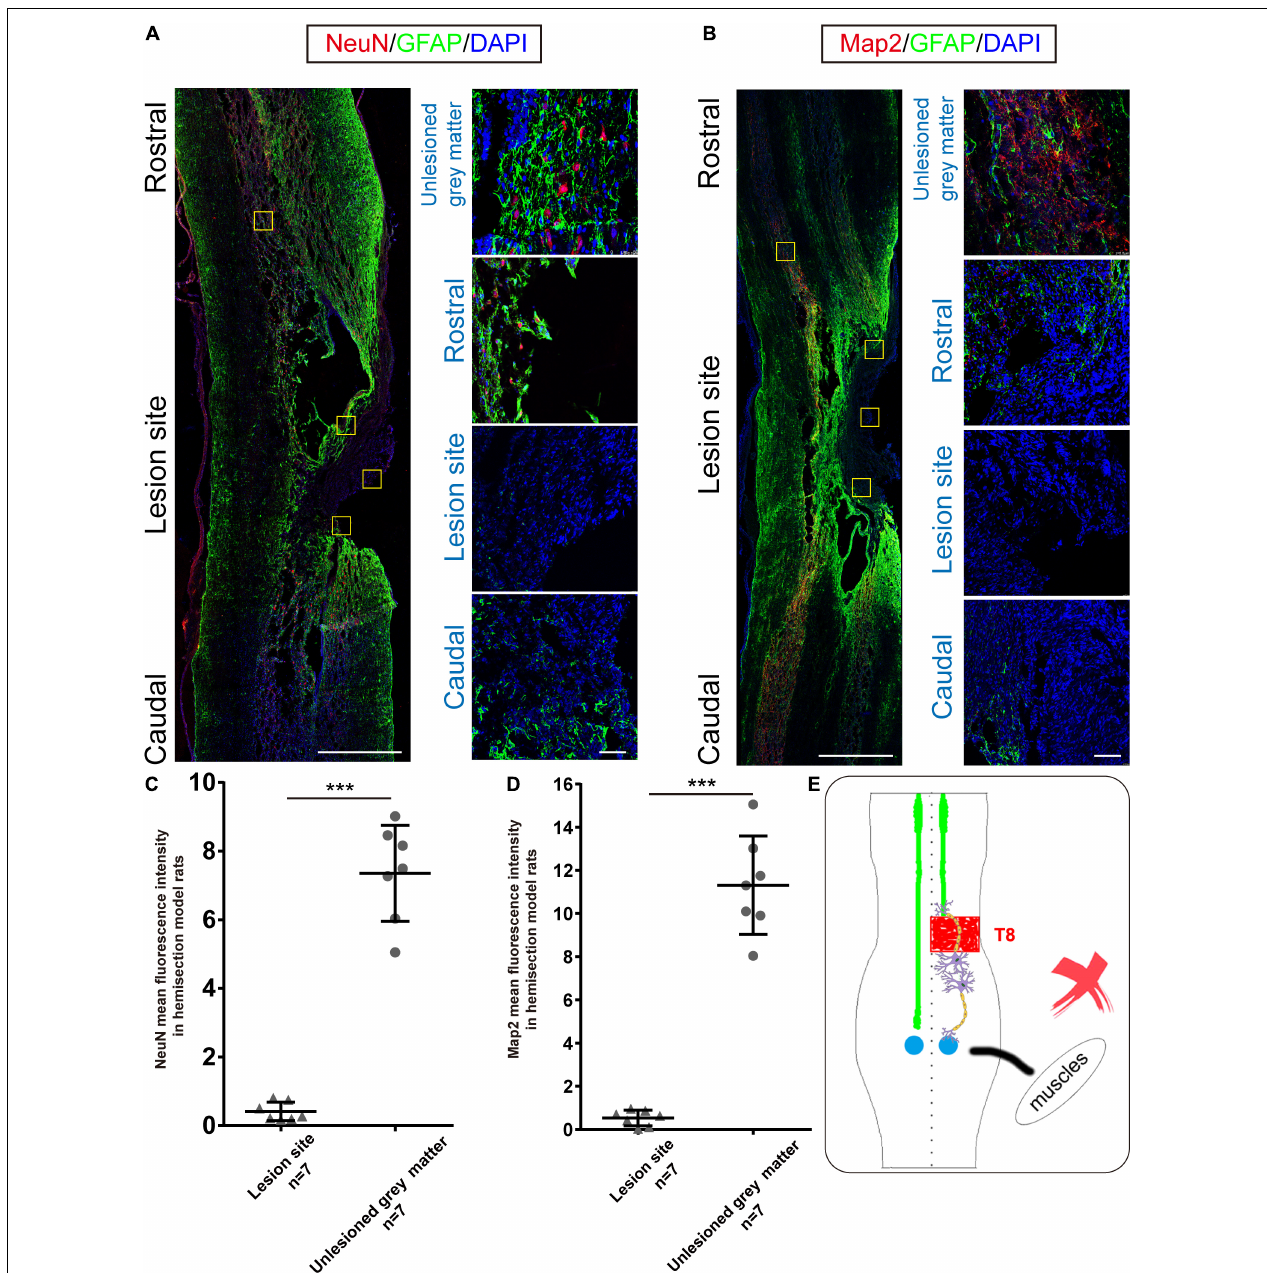
FIGURE 3 | Immunohistochemical analysis in hemisection model rats. (A,B) Representative longitudinal sections of the spinal cord in hemisection model rats at five weeks. Four small squares on the right are local amplification of the corresponding site in the left longitudinal section. (A) NeuN, GFAP, and DAPI triple-staining. (red: NeuN, green: GFAP, blue: DAPI). (B) Map2, GFAP, and DAPI triple-staining. (red: Map2, green: GFAP, blue: DAPI). (A,B) exhibit the 2 mm defect caused by the first hemisection in hemisection model rats, and little Map2/NeuN positive cells are detected in the lesion area. Quantitative data (C,D) showed that the intensity of NeuN/Map2 positive signal in the unlesioned gray matter was significantly higher than in the lesion area in hemisection model rats. (E) The sketch map shows the neurogenesis contributing to the spontaneous locomotor recovery; however, this probability is excluded in the hemisection model rats. Bars indicate mean with SD. Data are presented as the mean ± SD. *** P < 0.001. Animal numbers = 7 for immunostaining. Scale bar: (A,B) left 1 mm; right 50 µ m. NeuN indicates neuronal specific nuclear protein; Map2, microtubule-associated protein 2; GFAP, glial fibrillary acidic protein.